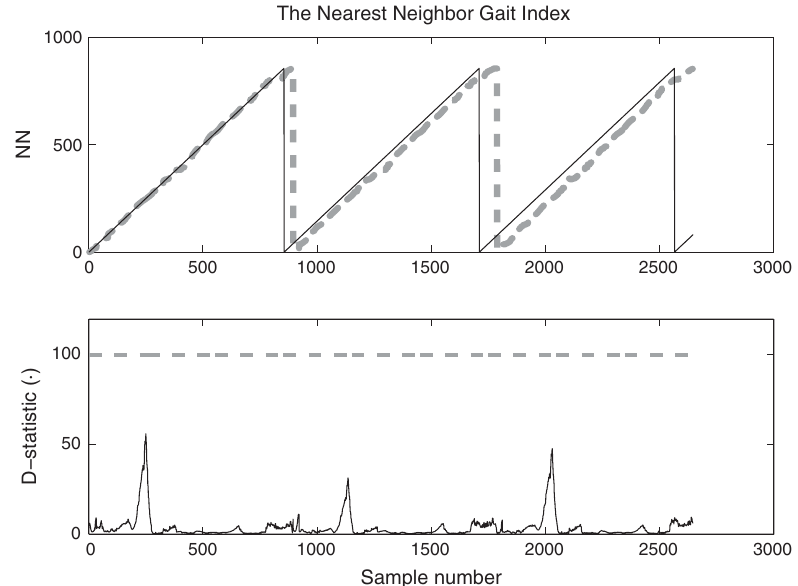
Fig. 6. Upper panel: the dotted line represents the NN for three consecutive stable strides as provided by the NNGI. The solid line corresponds to the RLC, the dashed line to the NNGI. The lower panel shows the D-statistic (solid line) and the selected threshold D th (dashed